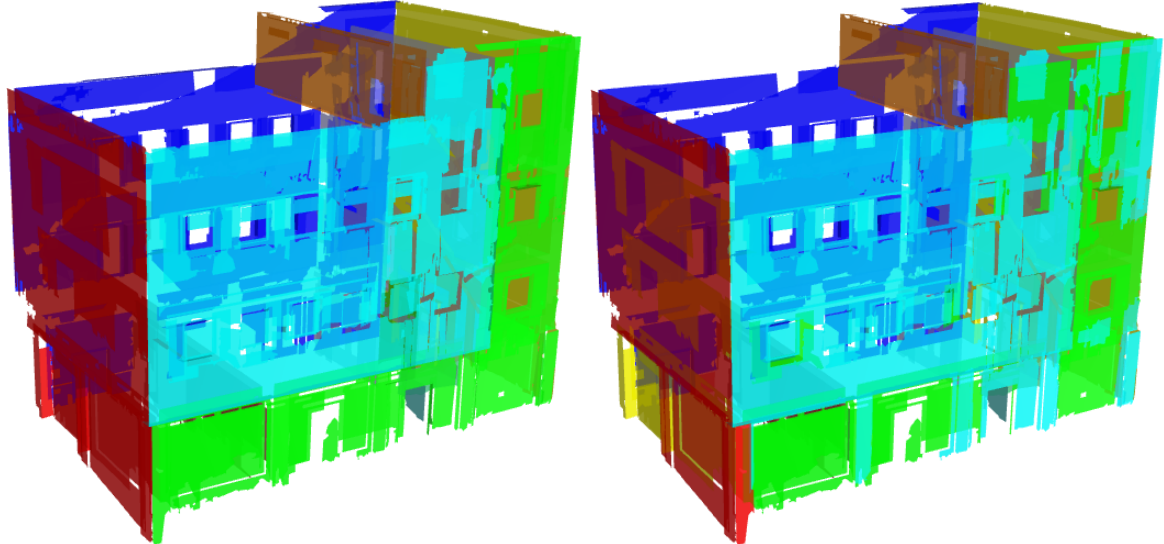
(b) Representation of the clustered wall segments using Condi- (a) Representation of the ground truth data with each wall in a tional Random Fields (CRF). seperate color. Figure 4: Test data set of a school facility on the